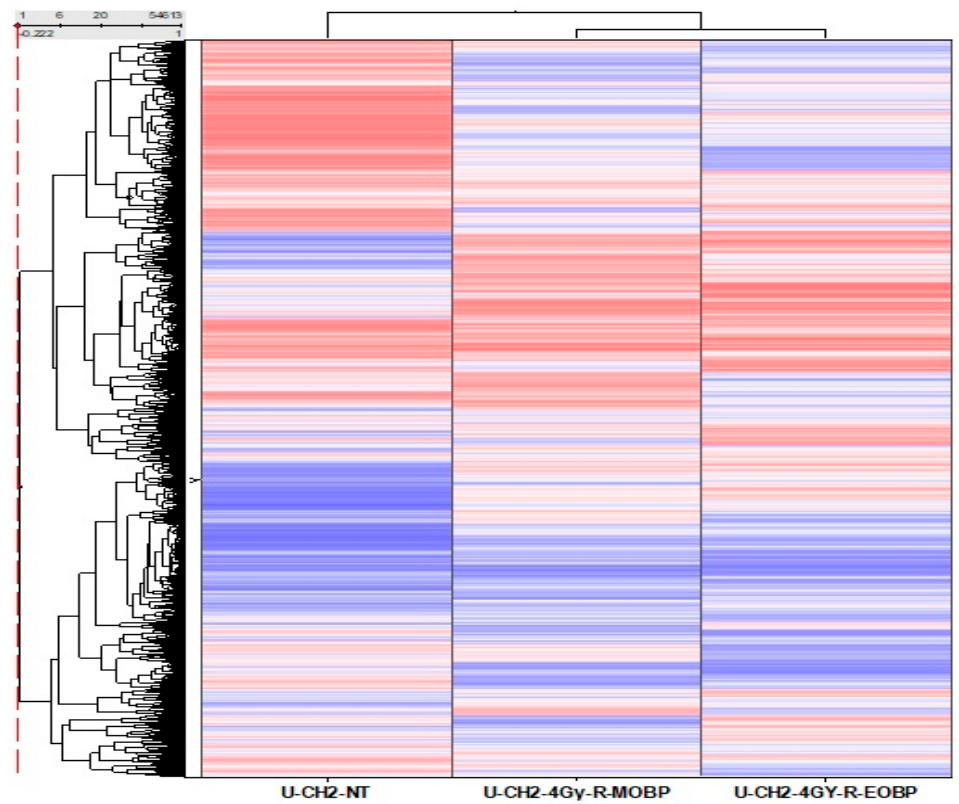
Figure 4. Gene expression profile of U-CH2 chordoma cells treated at middle (M-SOBP) and end of the Bragg (E-SOBP) peak of proton radiation.